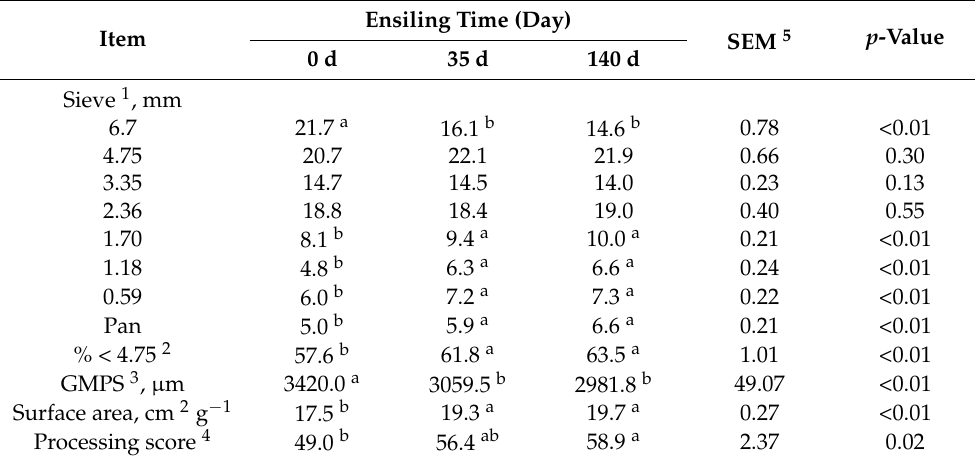
Table 9. Effect of ensiling time on kernel fraction particle size distribution, geometric mean particle size, surface area and processing score in whole-plant corn silage harvested with a self-propelled forage